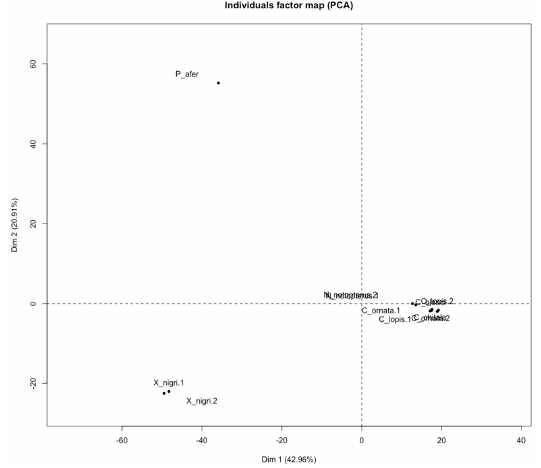
Figure 9. Principal component analyses of SNP data in DArTseq alleles found in the seven Notopteridae species analyzed ( Chitala ornata, C.blanci, C, lopis, C. chitala, N. notopterus, P. afer and X. nigri ). Individuals factor map using 3074 alleles (reference and alternative alleles). The notopterid specimens and presence/absence SNP were structured as observations (individual) and variable, respectively, as input matrix data.